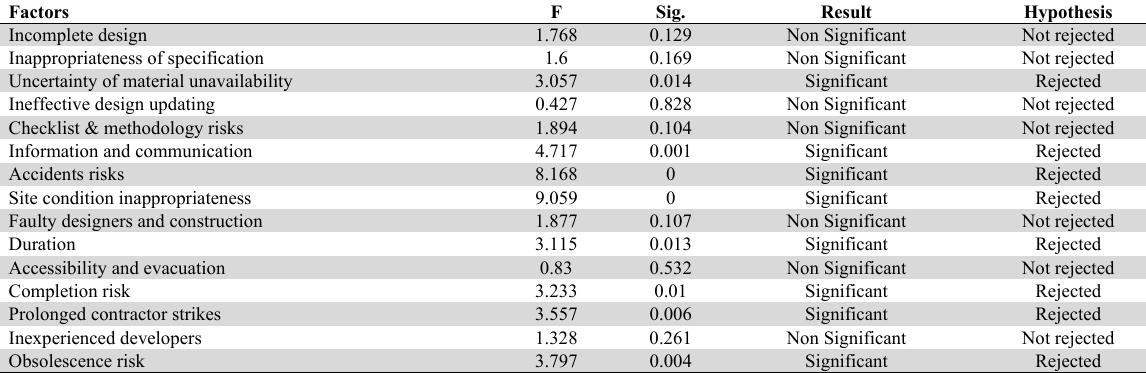
ANOVA Analysis Factors